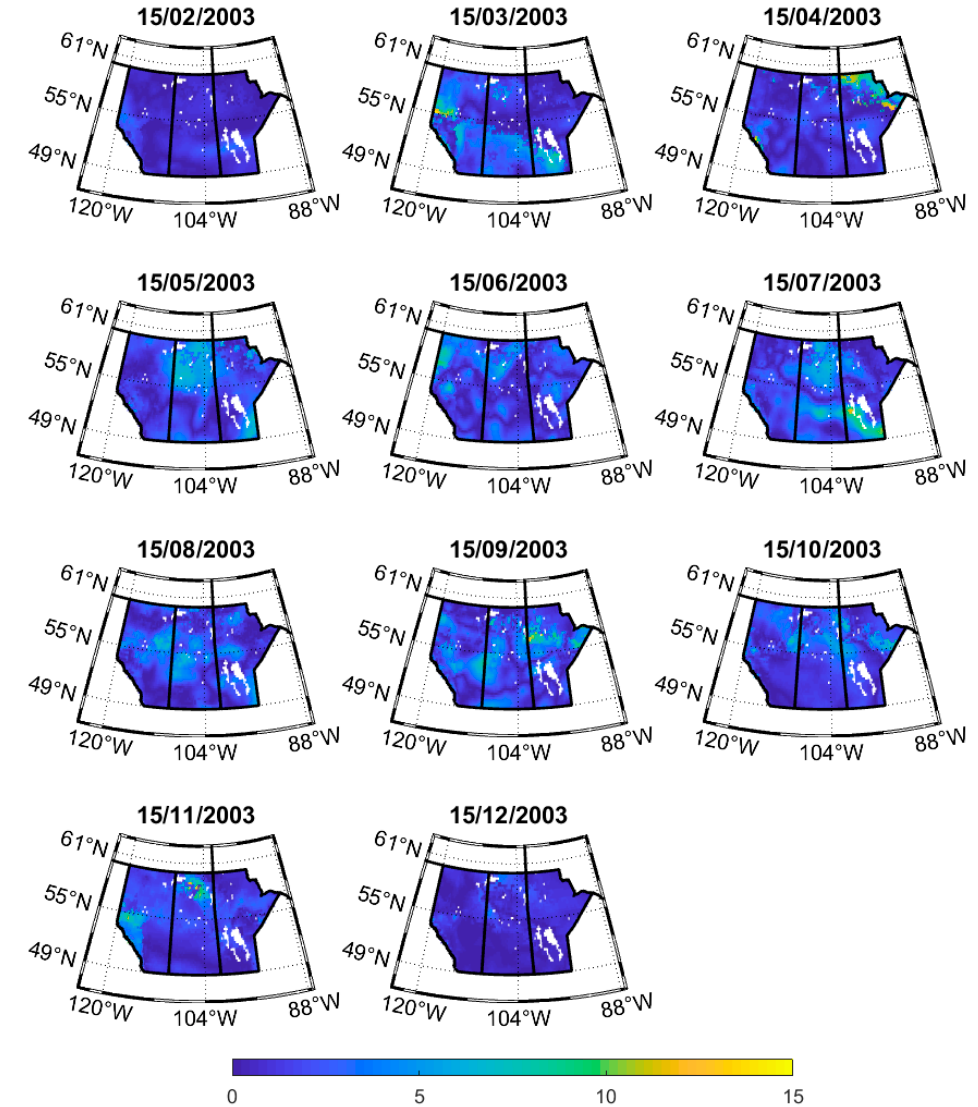
Figure 4. Estimated uncertainties of GLDAS TWS anomalies on the 15th day of each month between February and December 2003 [mm].